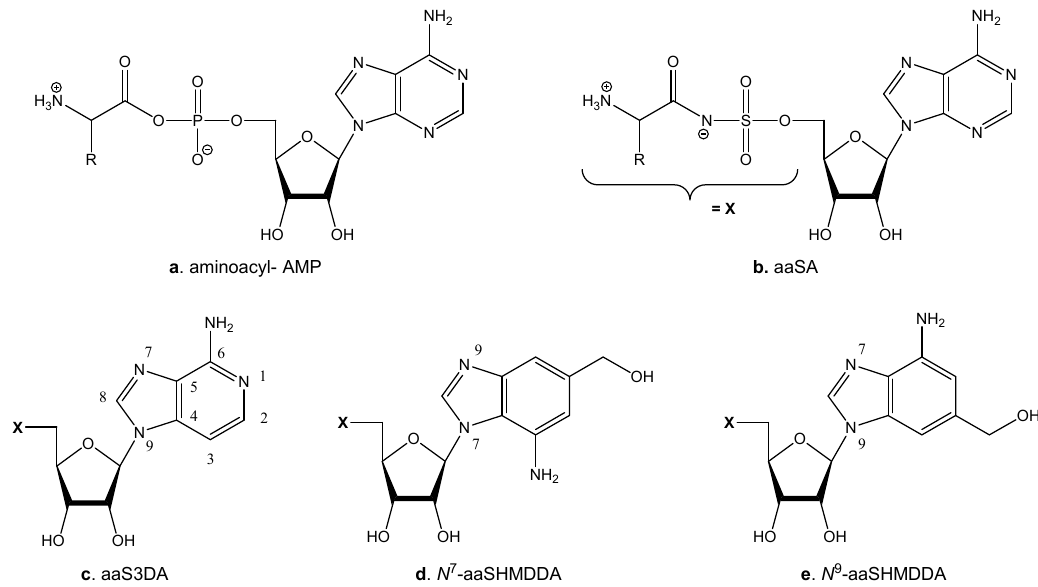
Figure 1. Chemical structures for ( a ) aminoacyl-adenylate; ( b ) aminoacyl-sulfamoyl adenosines; ( c ) aminoacyl-sulfamoyl 3-deazaadenosines; ( d ) the obtained N 7 -glycosylated 1,3-dideaza-2-hydroxy- methyl-adenosine (aaS7HMDDA), and ( e ) the desired N 9 -glycosylated analogues of 1,3-dideaza-2- hydroxymethyladenine (aaS9HMDDA). Atom numbering according to nucleoside nomenclature.